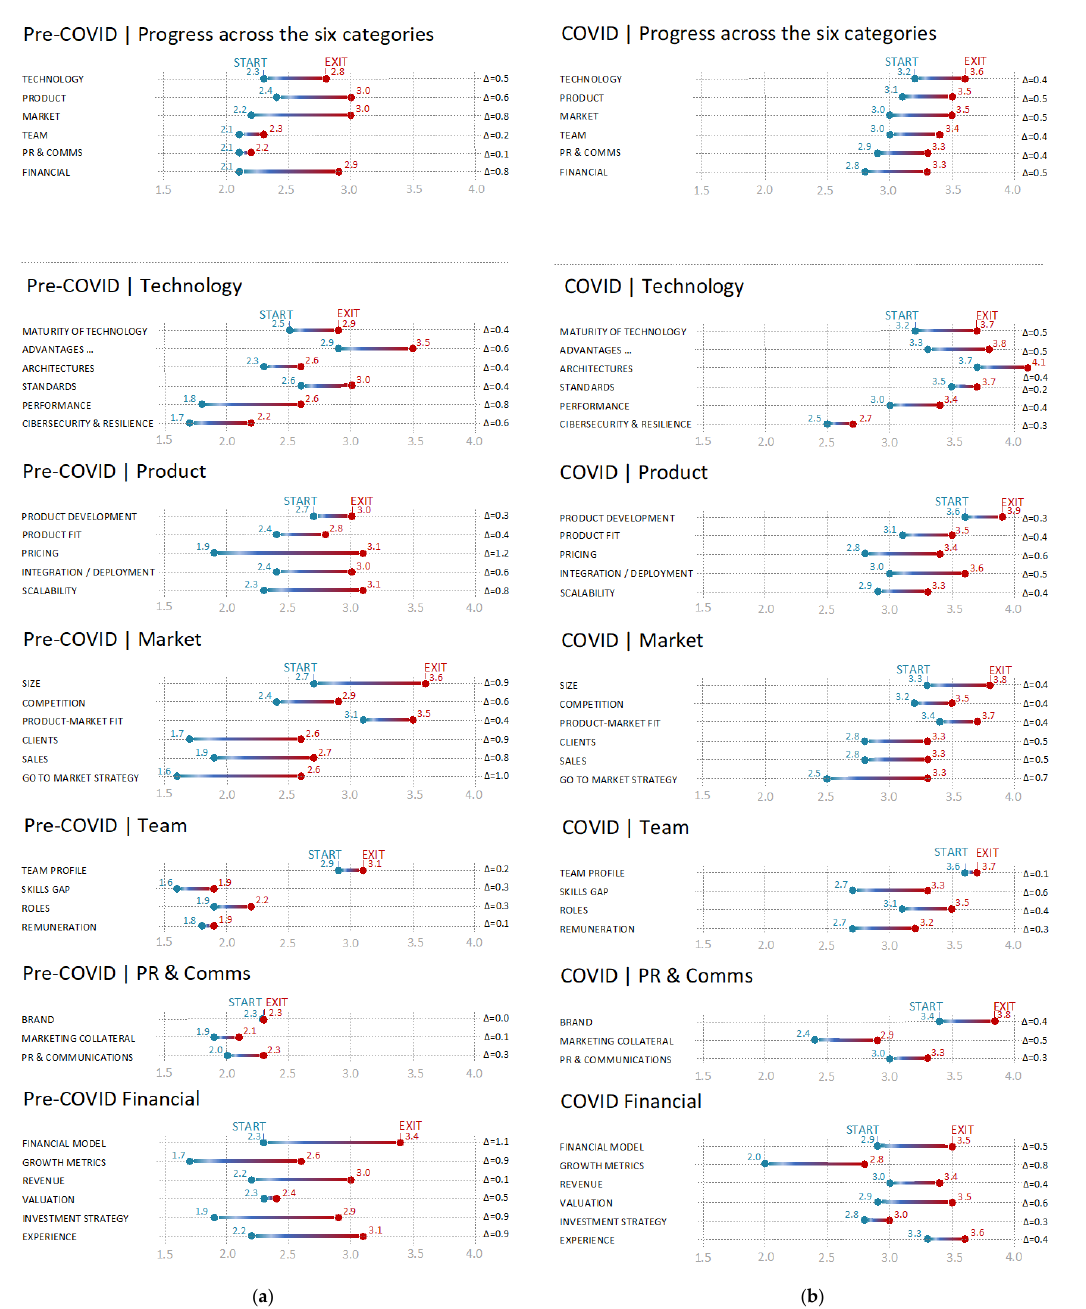
Figure 2. Average scores obtained by participants in each of the 30 indicators for the 6 categories considered at the beginning and at the end of the acceleration programme, together with the absolute increase in score achieved. ( a ) Pre-COVID acceleration programmes (2018 – 2019, Industrial Tech). ( b ) Into-COVID acceleration programmes (2020 – 2021, Space Tech).